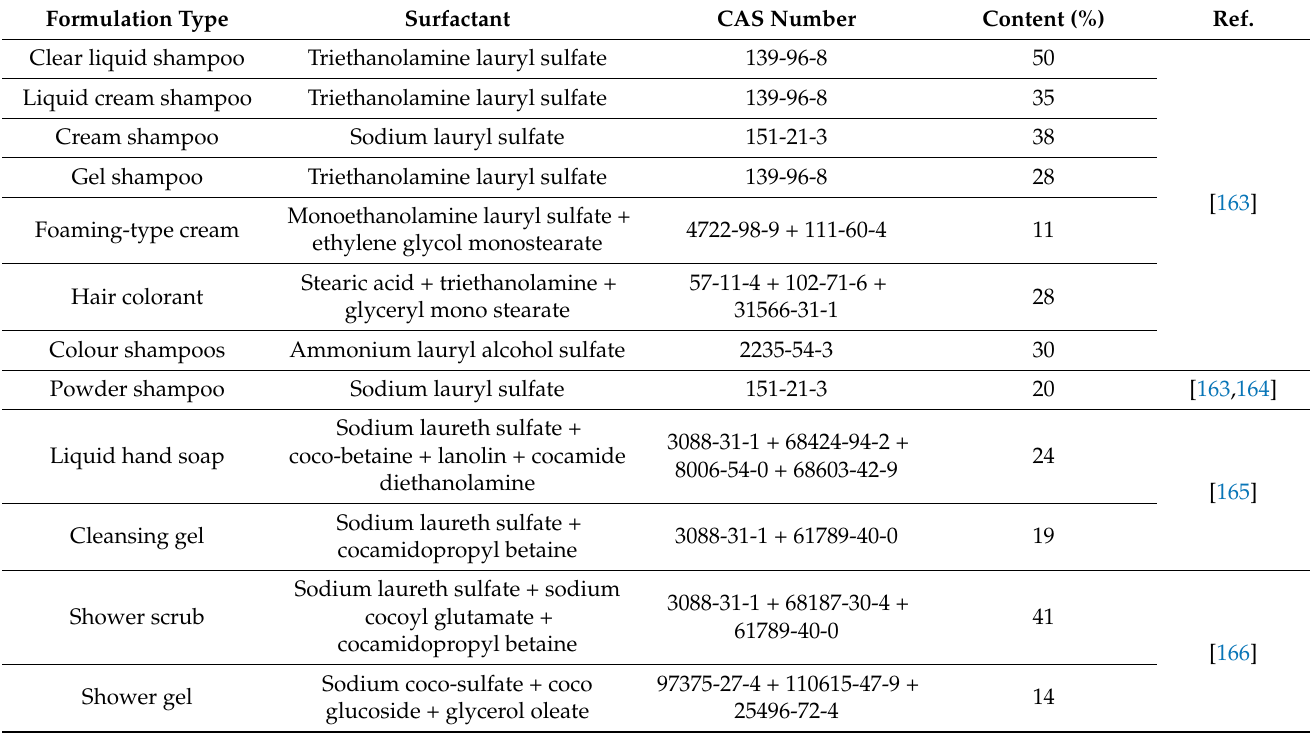
Table 4. Surfactant content in cosmetic, personal care and pharmaceutical